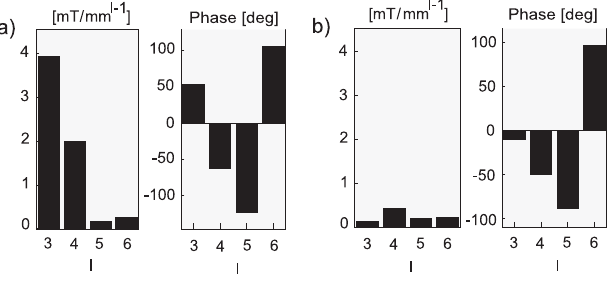
FIG. 8. HOMFC for the proof of principle are illustrated, which are obtained from azimuthal field measurements. Part (a) shows the HOMFC within a newly assembled quadrupole and (b) shows the PMQ tuned with significantly reduced HOMFC. The statistical errors obtained from independent mea- surements are between 0.1% and 0.7% for the values of the HOMFC, the phases are off between 0.3 (cid:2) and 1 (cid:2) , and are thus